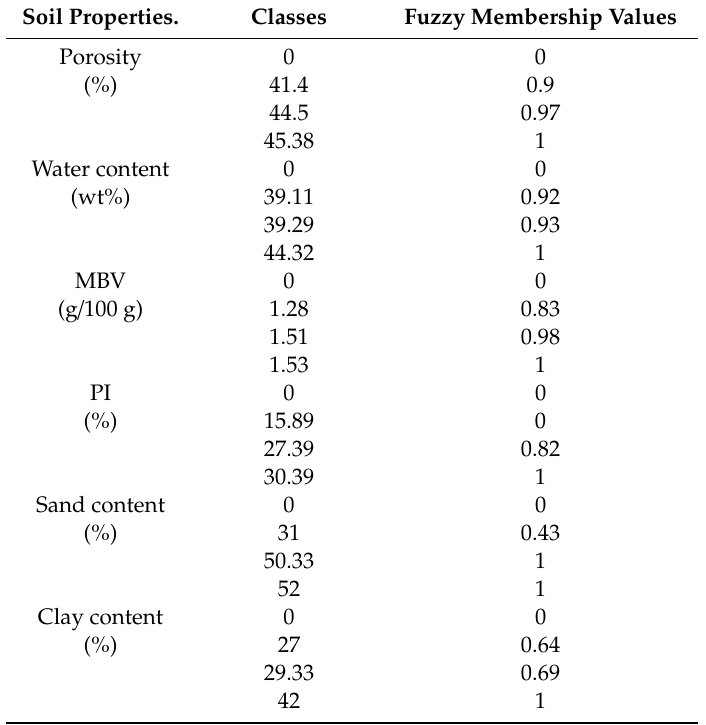
Table 6. Soil geomechanical properties whose increasing behavior augments the probability of landslide: porosity, water content, methylene blue value (MBV), plasticity index (PI), sand, and clay